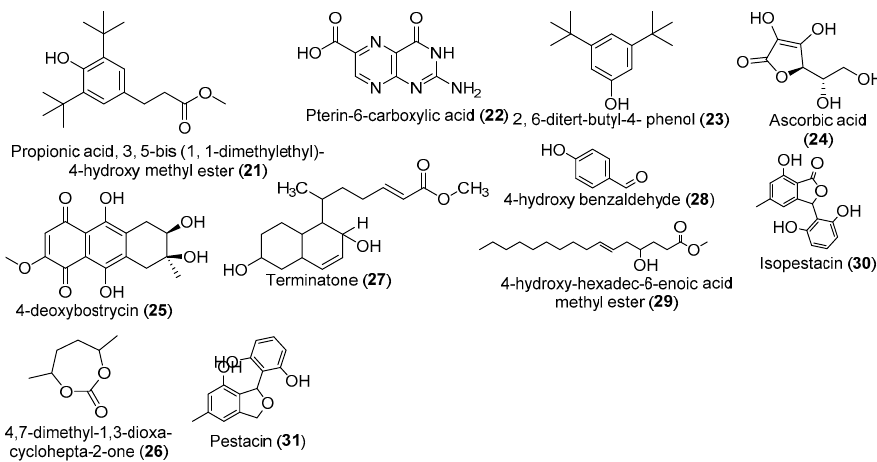
Figure 2. Metabolites isolated crude extracts with antioxidant activity.